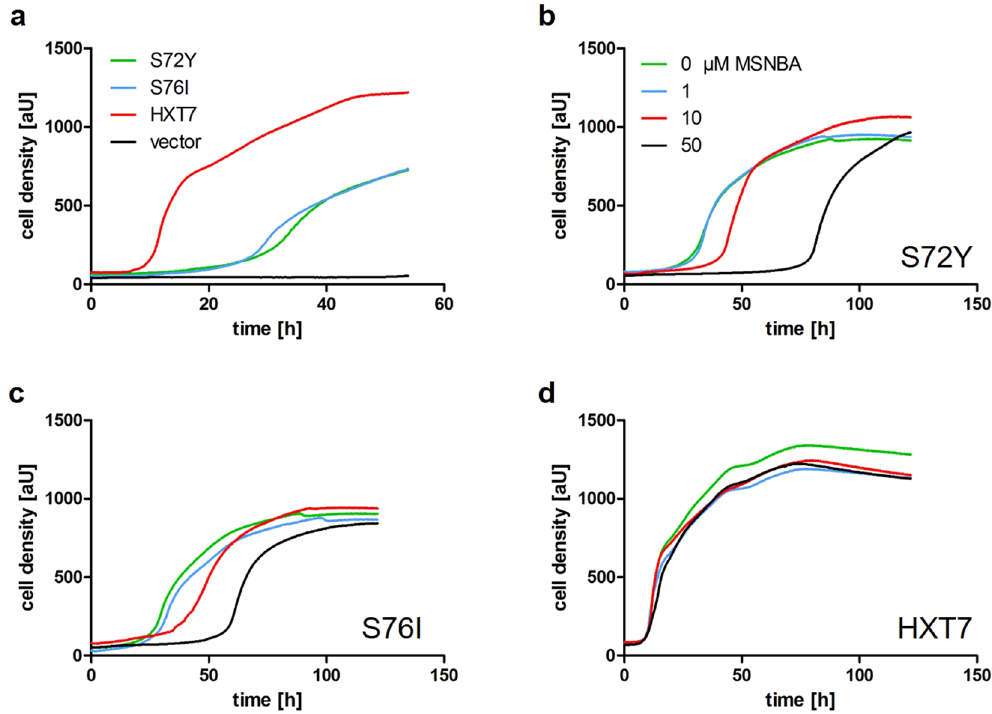
Figure 3. Growth analysis of GLUT5-transformed hxt 0 cells. ( a ) The EBY.VW4000 cells transformed with plasmids encoding GLUT5tr S72Y , GLUT5tr S76I or Hxt7 were cultivated in YEP media containing 1% (w/v) fructose and 200 µ g/ml of G418 for plasmid selection. The cells transformed with the empty vector were used as a negative control. The growth was measured using the Cell Growth Quantifier (Aquila Biolabs). ( b – d ) Indicated amount of MSNBA was added to the cultures and the growth was measured as in (a). The same color code is used throughout panels